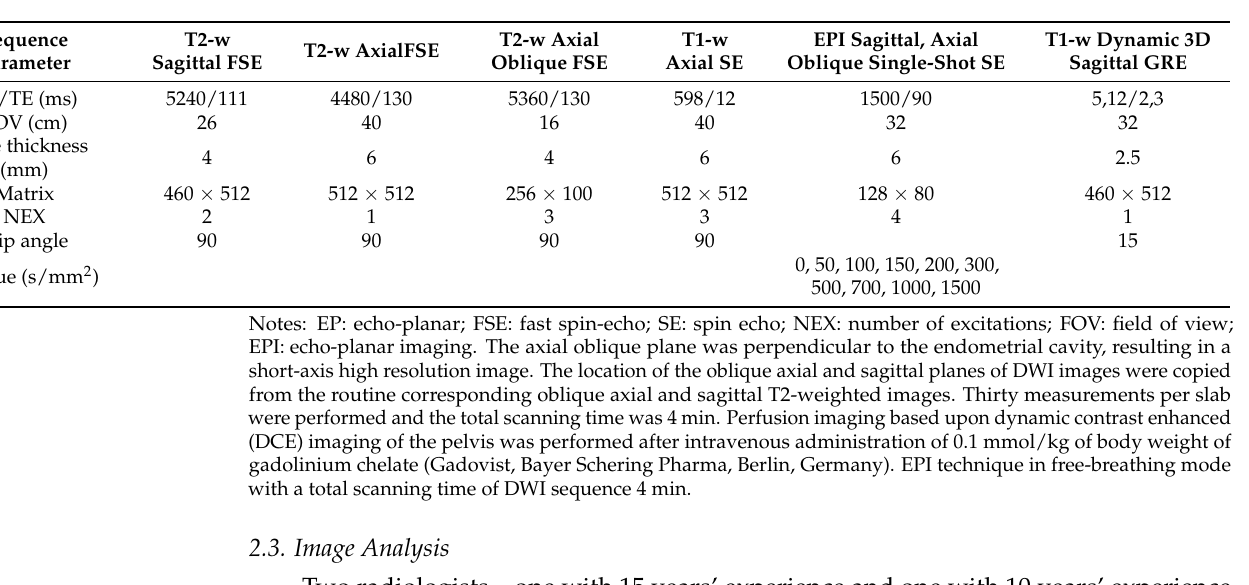
Table 2. MRI acquisition